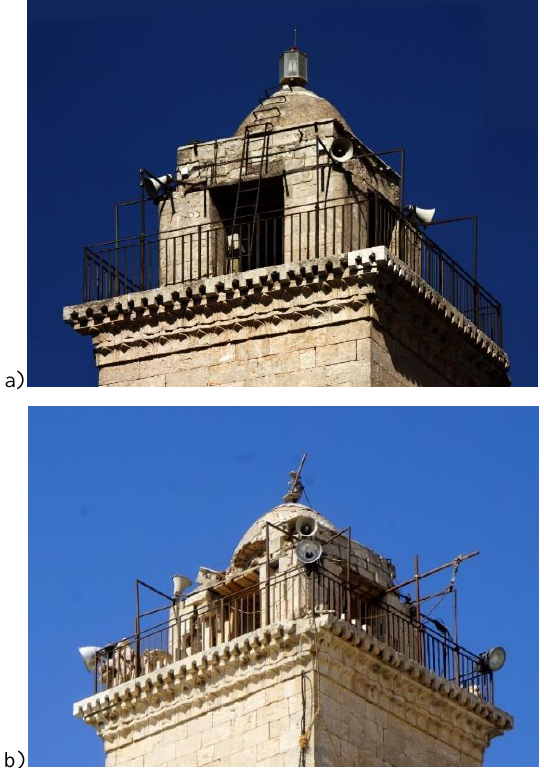
Figure 5: Minaret of the citadel mosque, current situation (a) and how it was in 2010 (b).